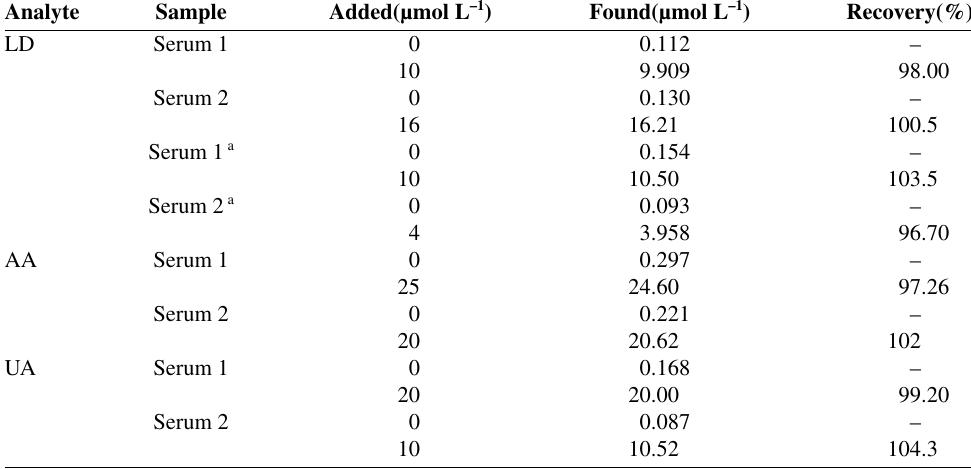
Table 1. Determination and recovery tests of LD, UA and AA in real samples obtained using PDB/MWCNTs-GC mo- dified electrode. Analyte